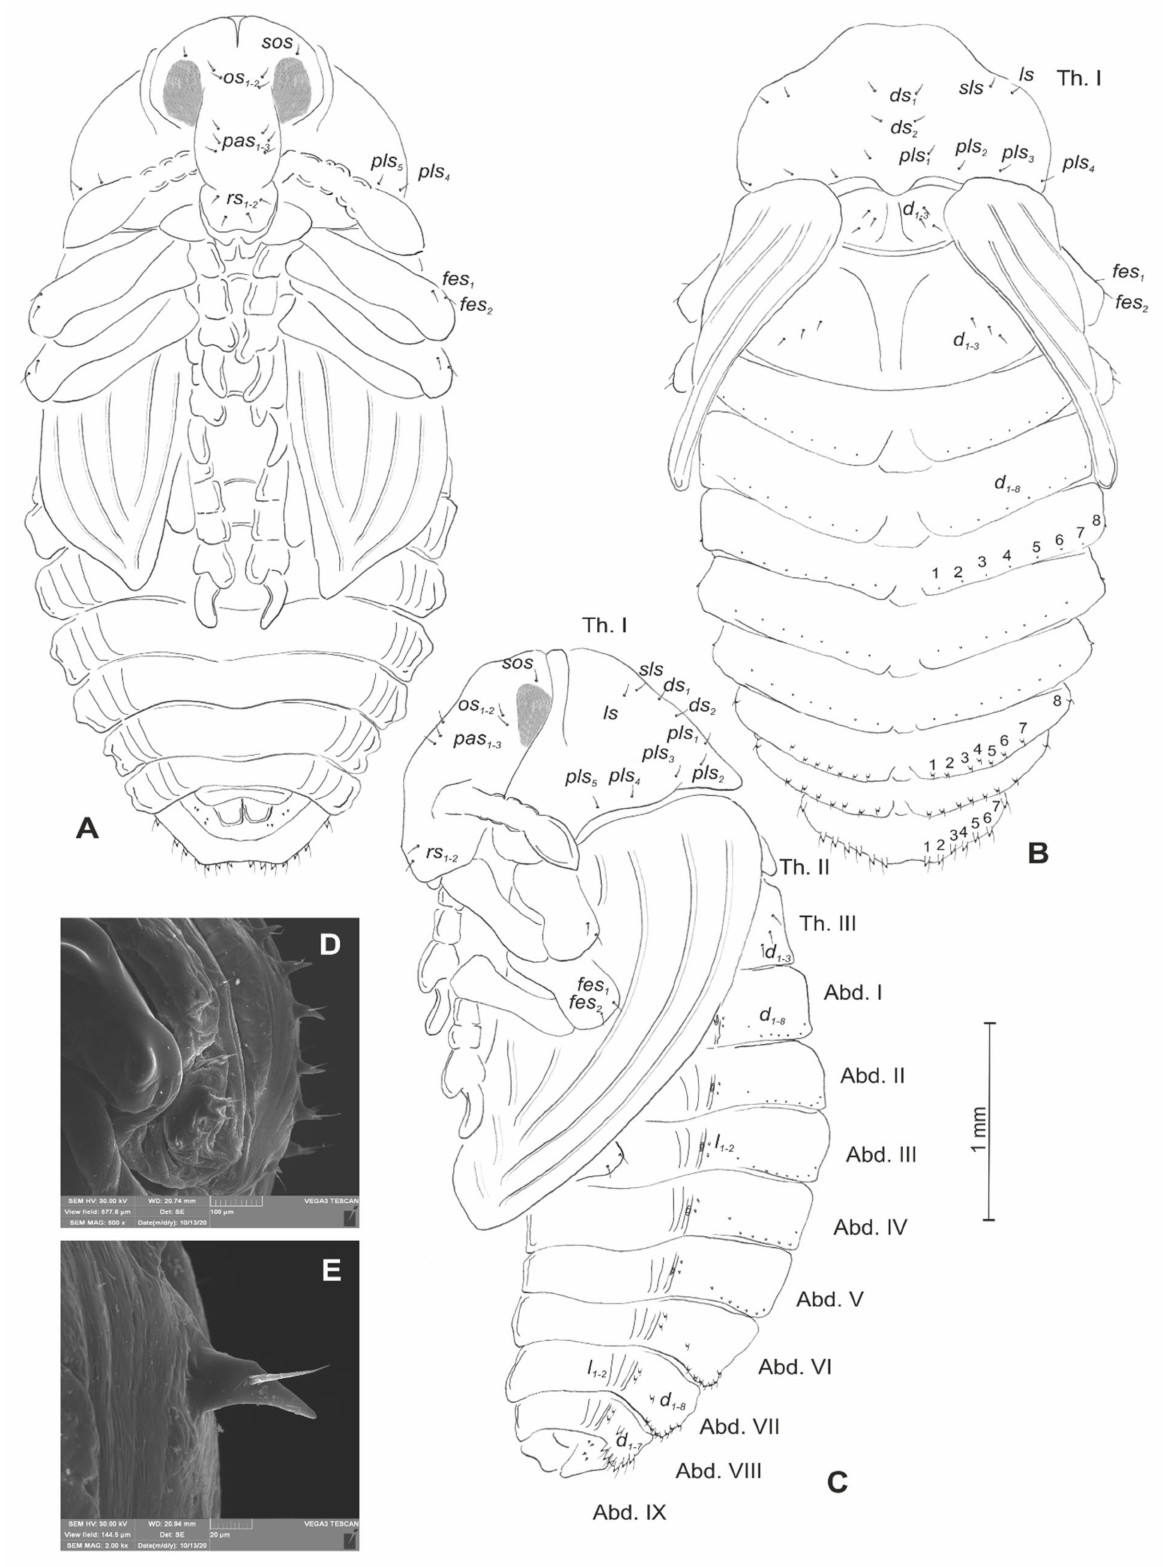
Figure 20. Rhinocyllus alpinus pupa. ( A )—ventral view; ( B )—dorsal view; ( C )—lateral view; ( D , E )—Abd. VIII, dorsal view, magnification (Th. I–III—pro–, meso– and metathorax, Abd. I–IX—abdominal segments 1–9, ur—urogomphus, setae: as —apical, d —dorsal, ds —discal, fes —femoral, ls —lateral, os —orbital, pas —postantennal, pls —posterolateral, rs —rostral, sls